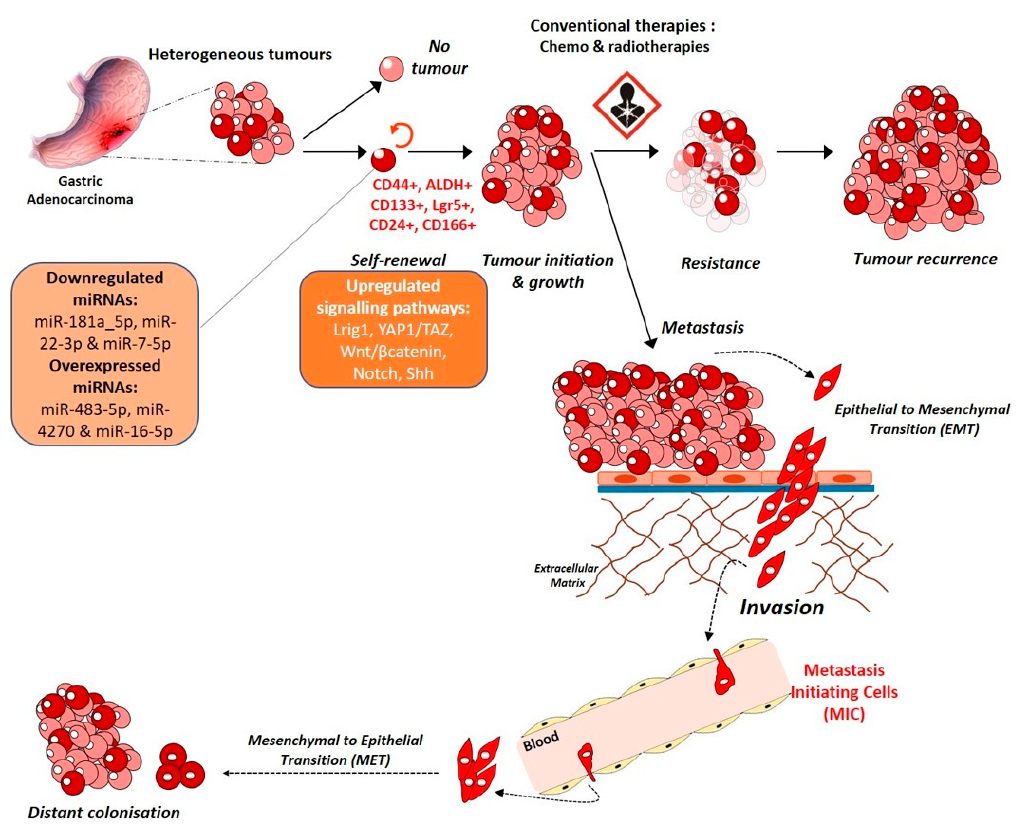
Figure 3. Gastric carcinogenesis: a stem cell disease.